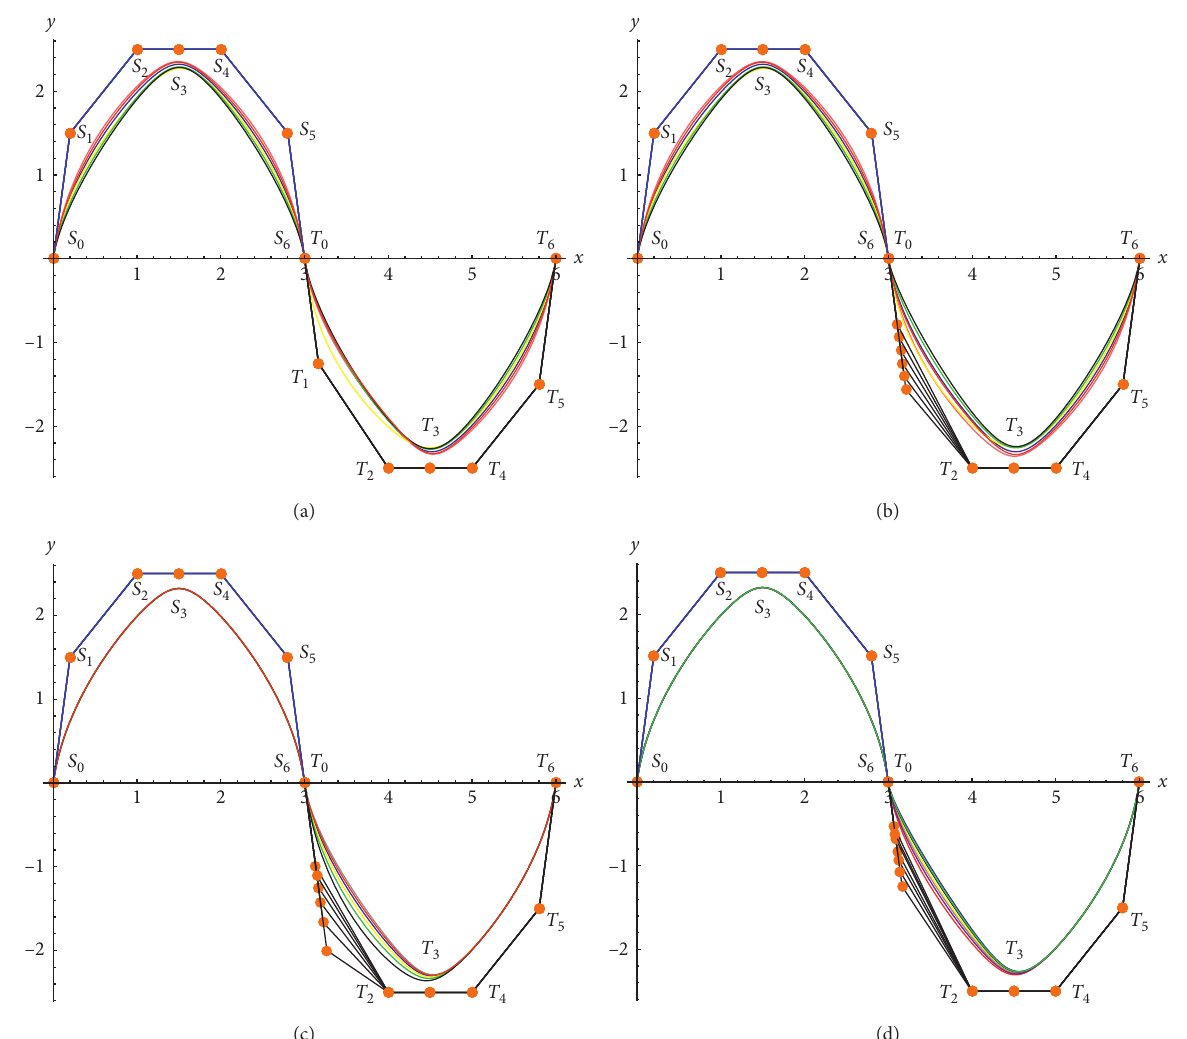
Figure 9: G 1 continuity of ST-B´ezier curve segments with various shape parameters. (a) μ � ω � μ 1 � ω 1 � 0 , 0 . 5 , 1 , − 1 , − 1 . 5 , − 2 , λ � 1 . 2. (b) μ � ω � 0 , 0 . 5 , 1 , − 0 . 5 , − 1 , − 1 . 5 , μ 1 � ω 1 � 0 , λ � 1 . 2. (c) μ 1 � ω 1 � 0 , 0 . 5 , 1 , − 0 . 5 , − 1 , 1 . 5 , μ � ω � 0 , λ � 1 . 2. (d) μ 1 � ω 1 � μ � ω � 0 , λ